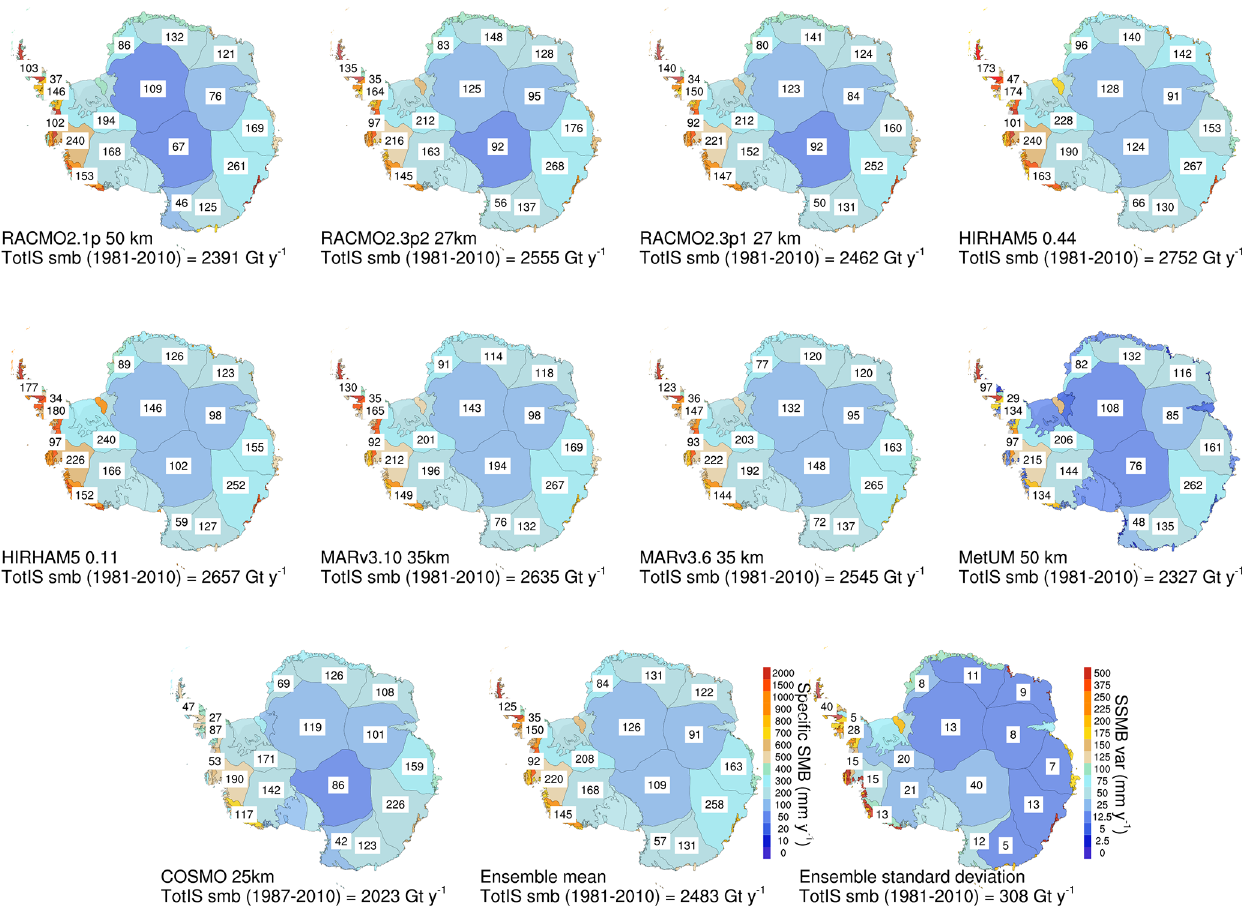
Figure 5. Integrated SMB and specific SMB (SSMB) for the nine models included in this study (RACMO2.1, RACMO2.3p2, RACMO2.3p1, HIRHAM5 50km, HIRHAM5 12.5km, MAR v3.10 , MAR v3.6 , MetUM, and COSMO-CLM 2 ) as well as the ensemble mean and standard deviation shown. Colours denote the SSMB in millimetres of water equivalent per year for all grounded ice sheet basins as well as the ice shelves these drain into, defined in Shepherd et al. (2019). The numbers included in the basins denote the basin-integrated SMB in Gtyr − 1 for the grounded ice sheet for the period 1980 to 2010 with the exception of COSMO-CLM 2 , where the time series starts in 1987. Finally, the total integrated number for the grounded ice sheet including ice shelves is shown in the figure